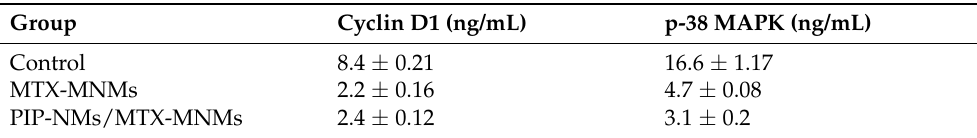
Table 3. Levels of cyclin D1 and p-38 MAPK of MTX-MNMs and PIP-NMs/MTX-MNMs -treated groups as compared to the control group. Data represented as mean ± SD ( n = 7).